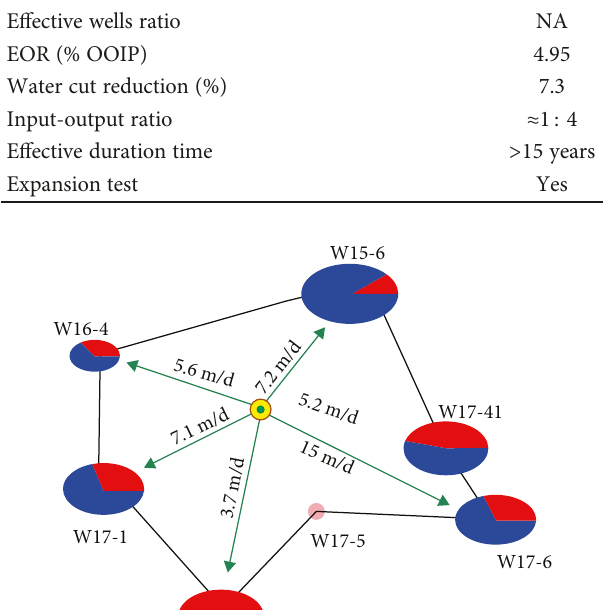
Figure 14: Luo 801 production curve and decline forecast [65].